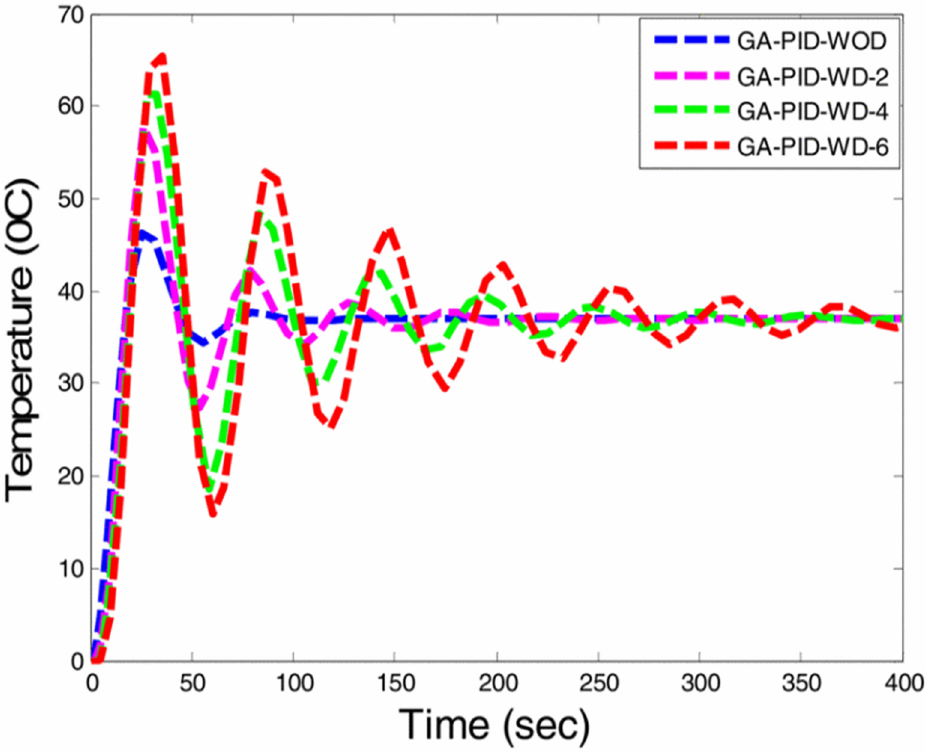
Figure 9. Ambulance output comparison plot of PID Controller and ga in terms of time and temperature.